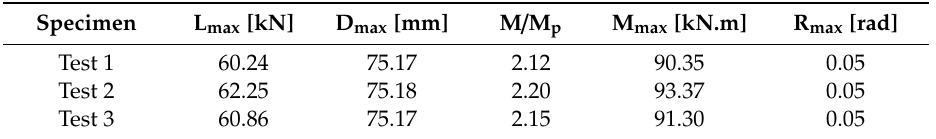
Table 4. Summary of maximum values obtained in